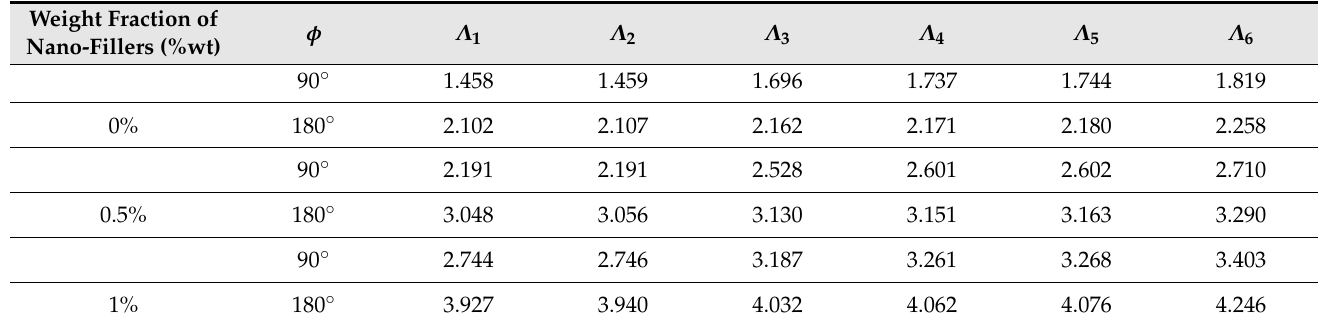
Table 5. Buckling loads (GPa) of an FG-GPL, porous spherical cap for various polar angle and weight